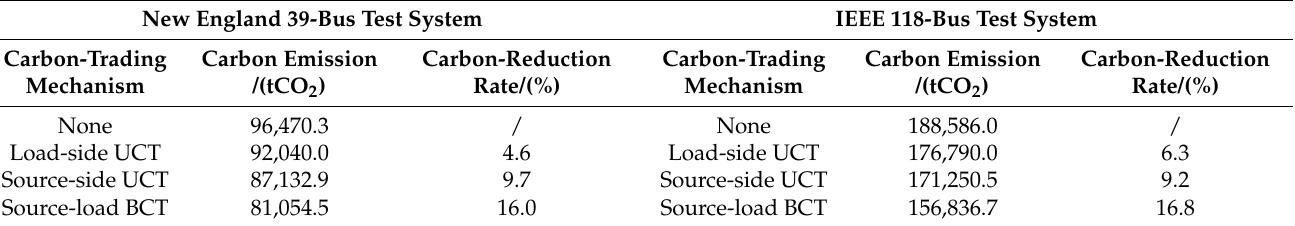
Table 6. Comparison results of carbon emissions under different carbon-trading mechanisms in the two